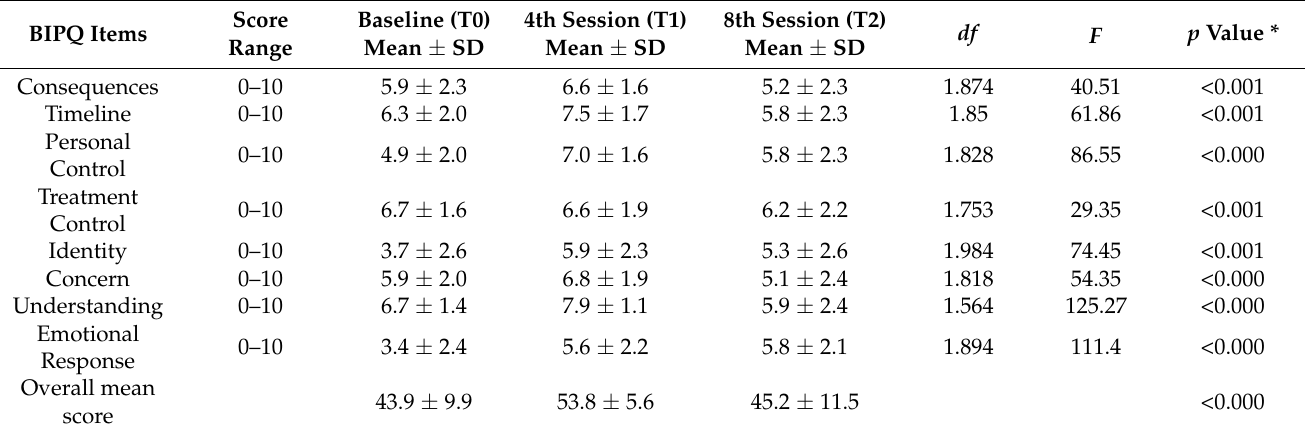
Table 4. Changes of Illness Perception at T0, T1 and T2.